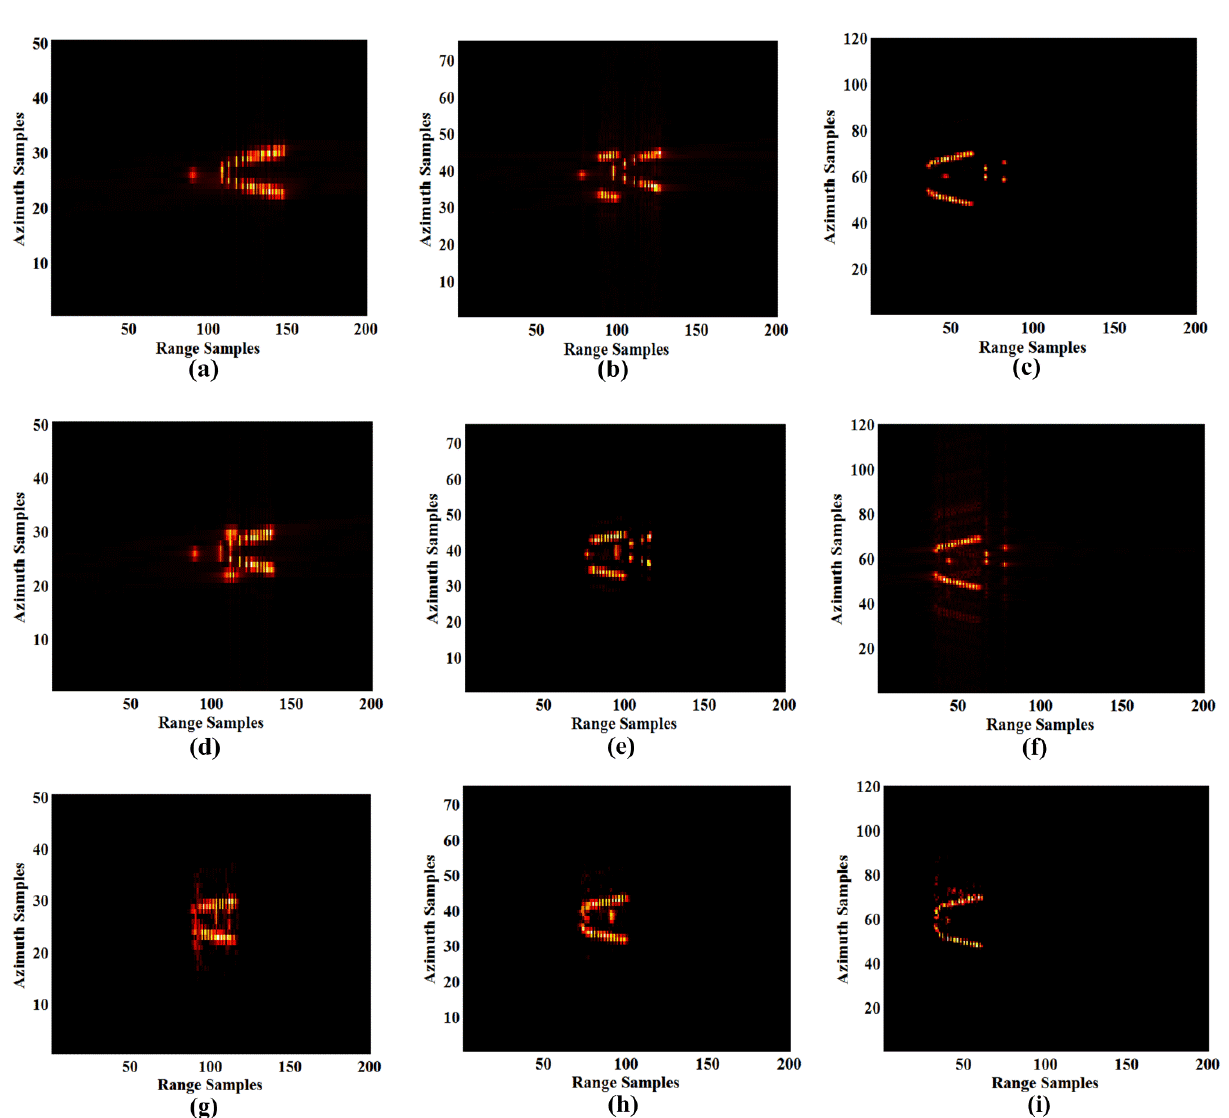
Figure 21. ISAR image of the hypersonic target in scenes 1, 2, and 3 using X-band, Ku-band, and Ka-band radar. ( a ) X-band in scene 1. ( b ) Ku-band in scene 1. ( c ) Ka-band in scene 1. ( d ) X-band in scene 2. ( e ) Ku-band in scene 2. ( f ) Ka-band in scene 2. ( g ) X-band in scene 3. ( h ) Ku-band in scene 3. ( i ) Ka-band in scene 3.